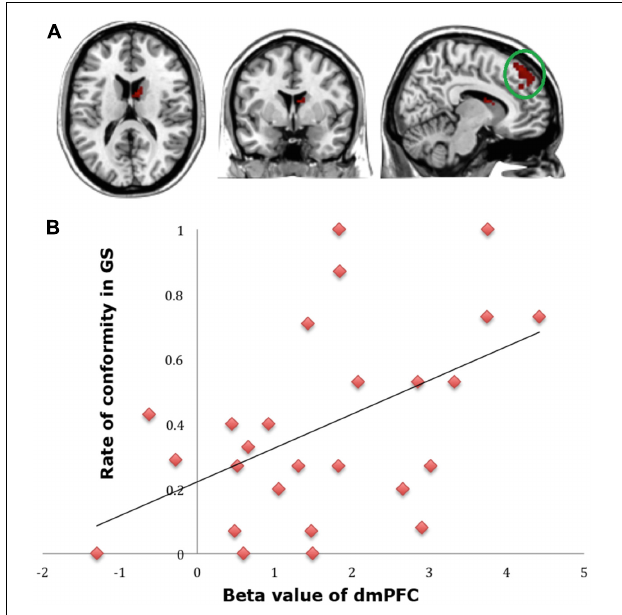
FIGURE 4 | (A) Brain regions involved in advantageous inequity influence (generous offer–selfish influence > generous offer–no social influence), p < 0.001, cluster size = 10, uncorrected. dmPFC was marked with a green circle. (B) dmPFC β -values for the advantageous inequity influence effects